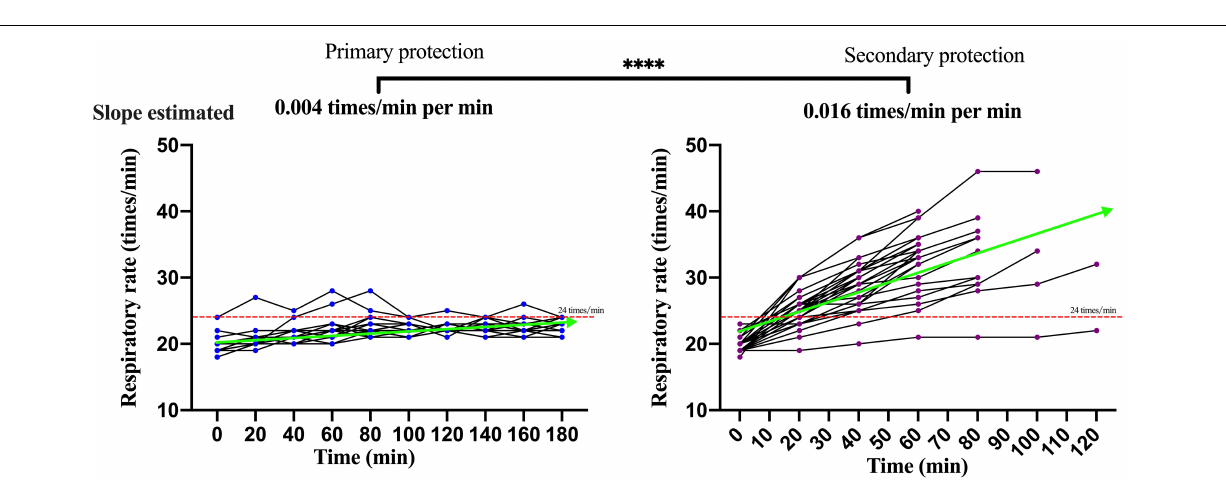
FIGURE 4 | The dynamics of axillary temperature of participants with primary and secondary PPE. ∗∗∗∗ p < 0.0001. The slopes of axillary temperature during the trial were calculated by generalized estimating equations. PPE, personal protective equipment.